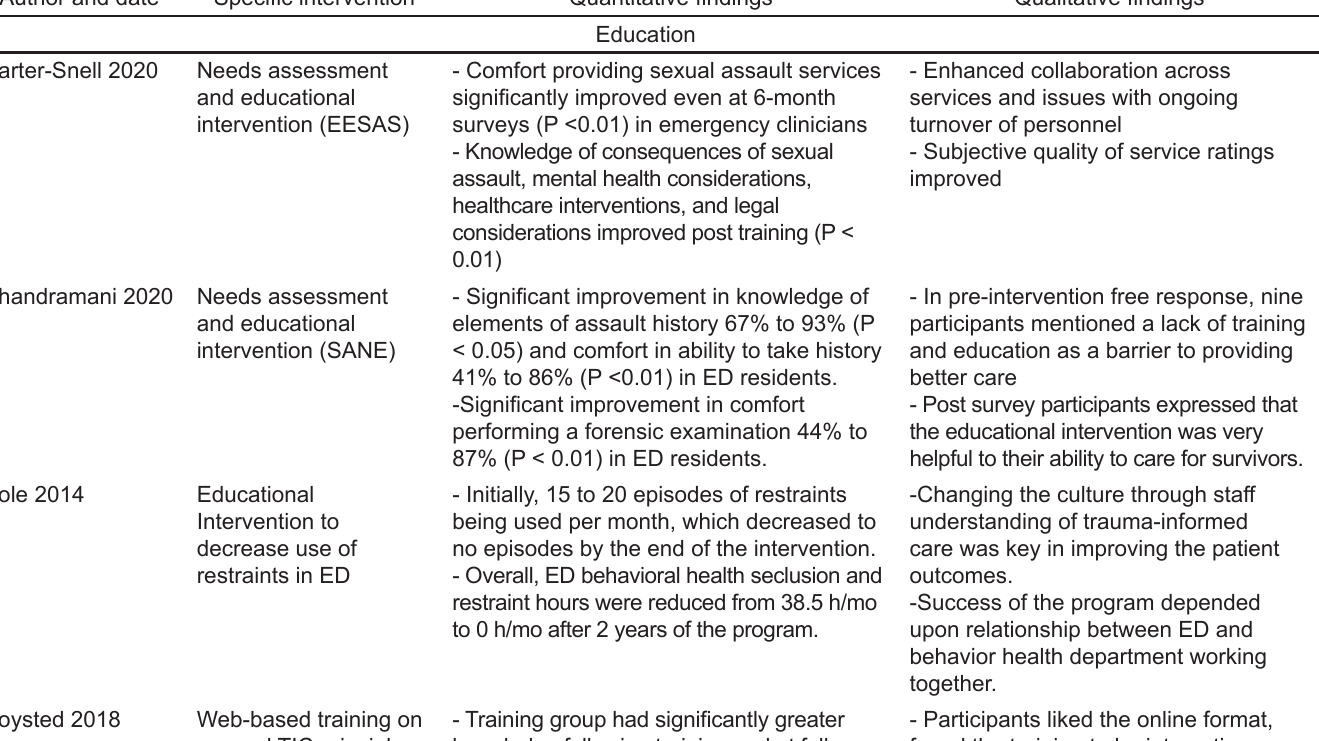
Table 2. Major quantitative and qualitative findings for included